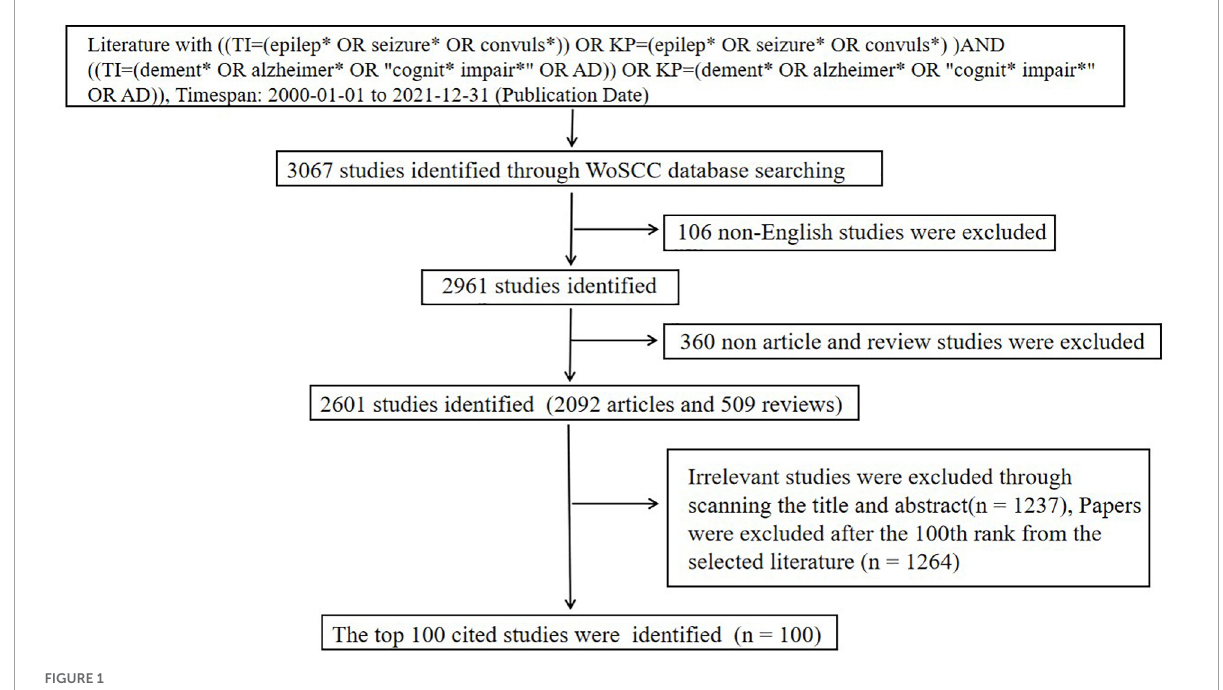
FIGURE1 Flow chart of literature